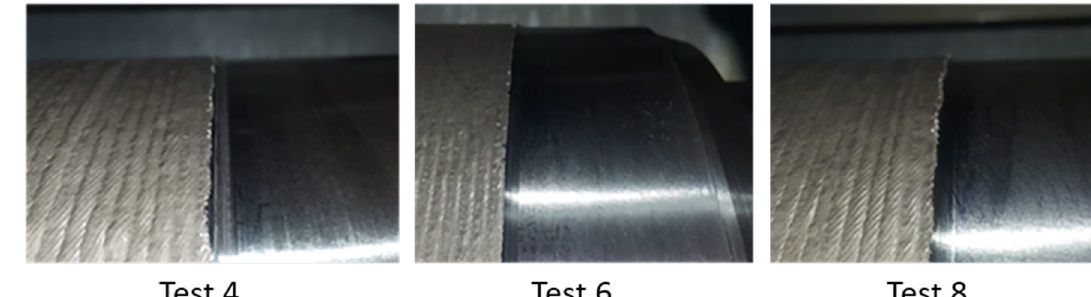
Figure 5. Burrs formation in the machined workpieces